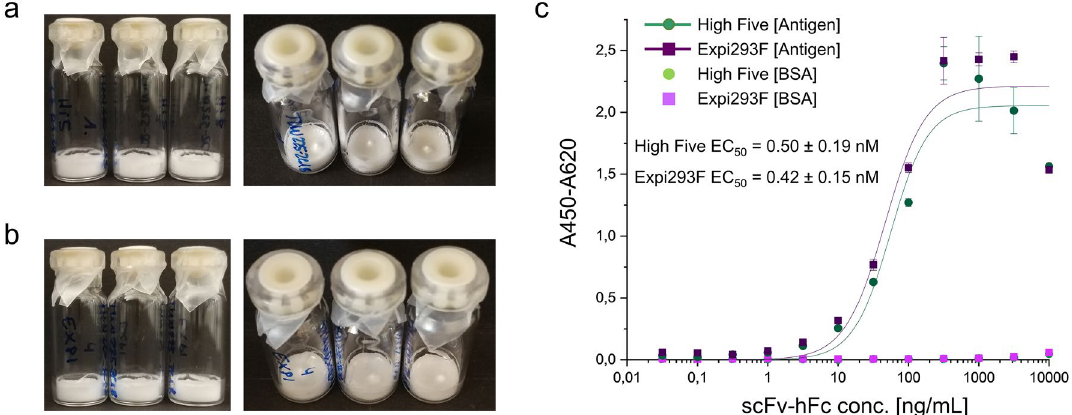
Figure 6. Lyophilization of TUN219-2C1-hFc produced in High Five cells and Expi293F cells. ( a ) Lyophilization cakes of scFv-hFc produced in High Five cells and ( b ) produced in Expi293F cells. ( c ) Antigen ELISA after